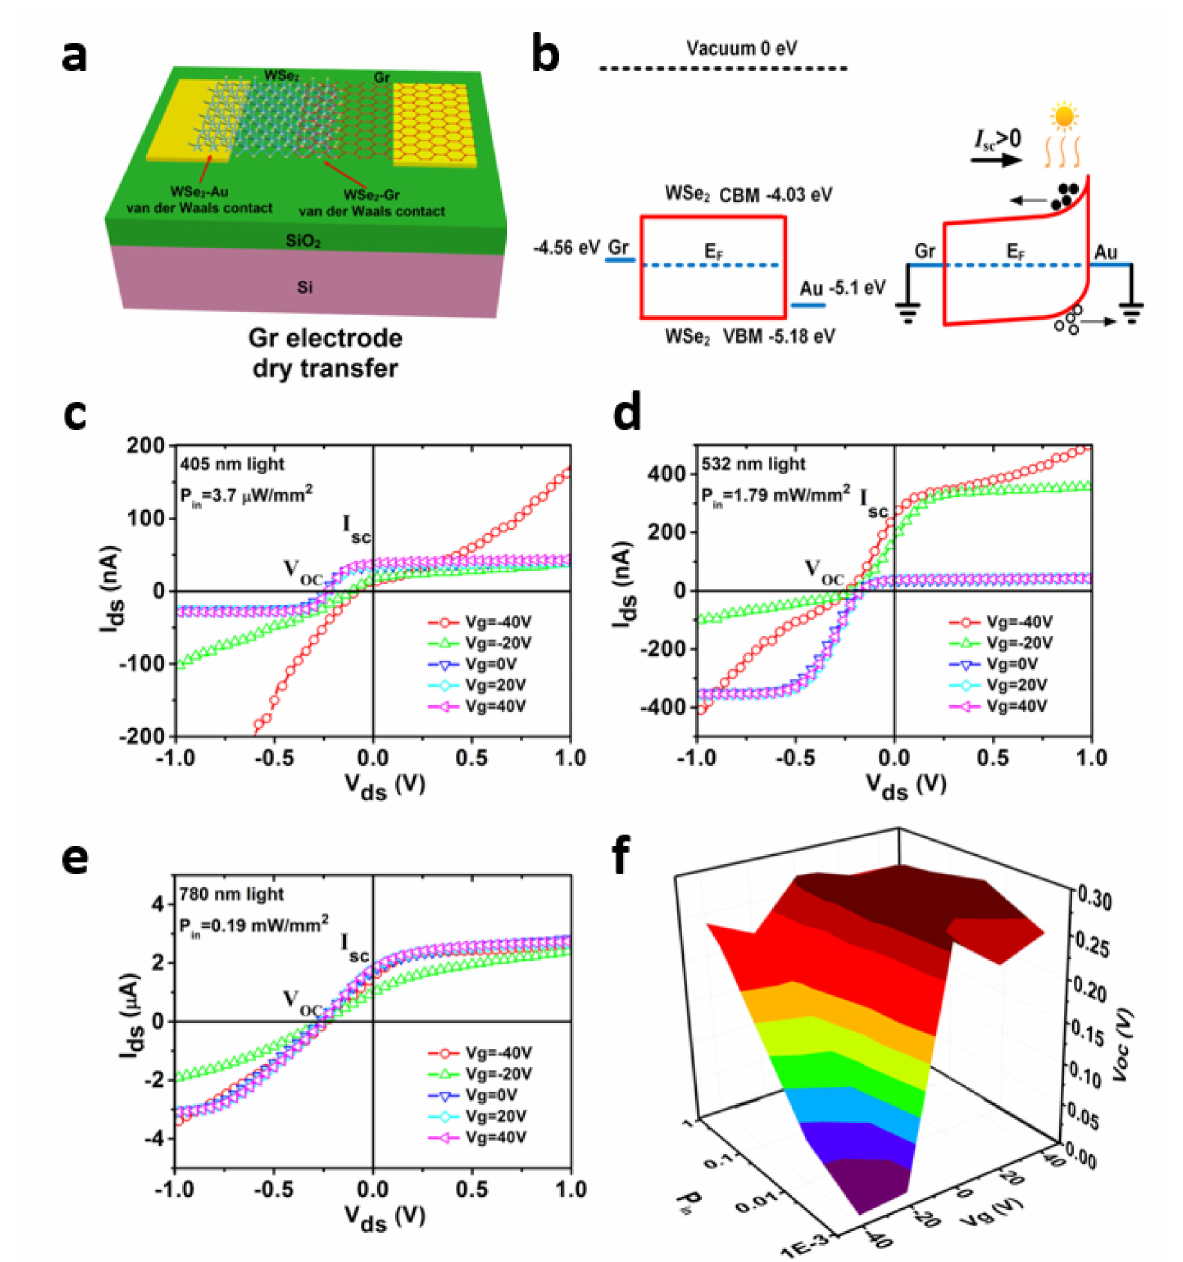
Figure 4. ( a ) A simple illustration of a graphene-WSe 2 -Au photodetector. ( b ) Energy band diagram of a device composed of graphene-WSe 2 -Au. Graphene and Au were used as electrodes. Current–voltage characteristics of graphene-WSe 2 -Au photodetectors are shown at wavelengths of ( c ) 405 nm, ( d ) 532 nm, and ( e ) 780 nm. ( f ) Dependence of the open-circuit voltage (Voc) on gate voltage bias and light power density at 780 nm illumination. Reproduced with permission from [65]. Copyright 2020, Springer